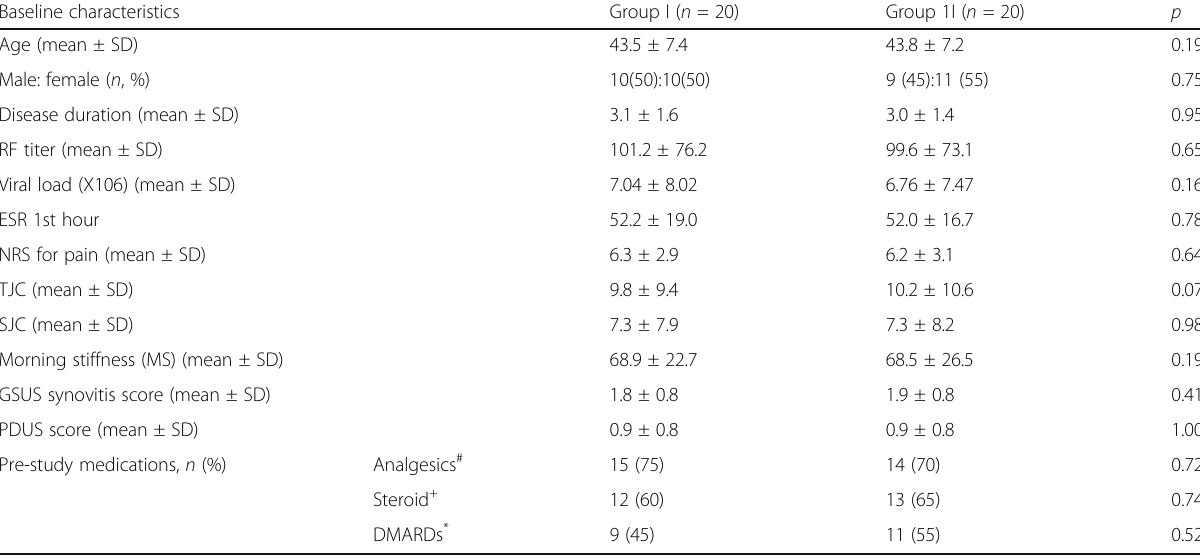
Table 1 Baseline characteristics (demographic, clinical, laboratory, ultrasonographic, and pre-study medications) of both groups Baseline